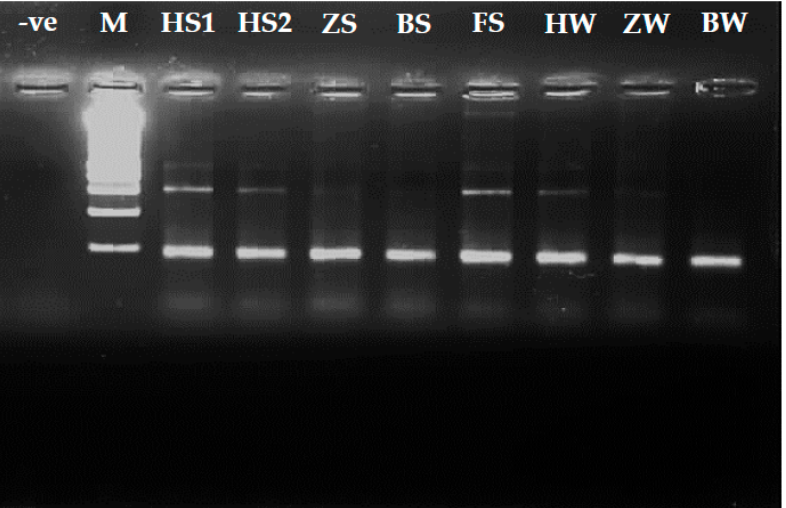
Figure 2. 16S rRNA PCR-amplification products of DNA extracted from water and sediment/salt crystal samples from soda lakes in Wadi El-Natrun. Lane –ve: without DNA (control); Lane M: 1 kb DNA ladder; Lanes HS1 and HS2: sediment and salt crystals from El-Hamra Lake, respectively; Lane ZS: sediment from Zugm Lake; Lane BS: salt crystals from Beida Lake; Lane FS: sediment sample from El-Fazda Lake; Lanes HW, ZW and BW: water samples from El-Hamra, Zugm, and Beida lakes, respectively.